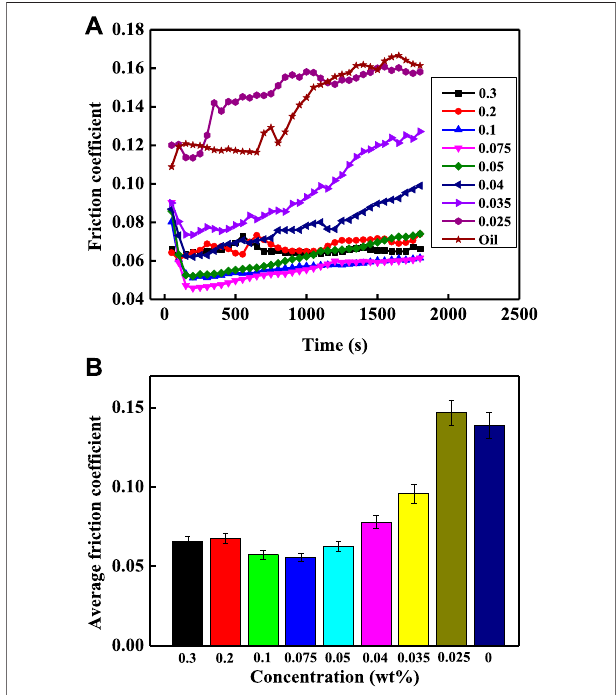
FIGURE 6 | Wear morphology images of (A) GCr15 ball surfaces and (B) GCr15 disk surfaces for different nanoparticle concentrations.